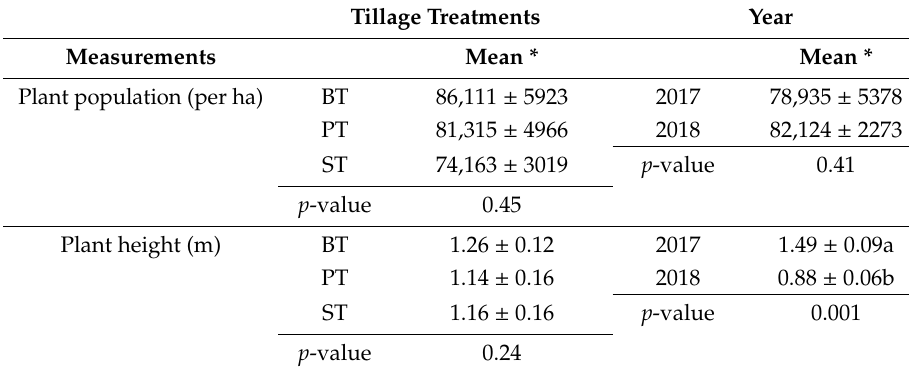
Table 1. Population and height of cotton plants measured under the tillage treatments in Las Cruces (2017 and